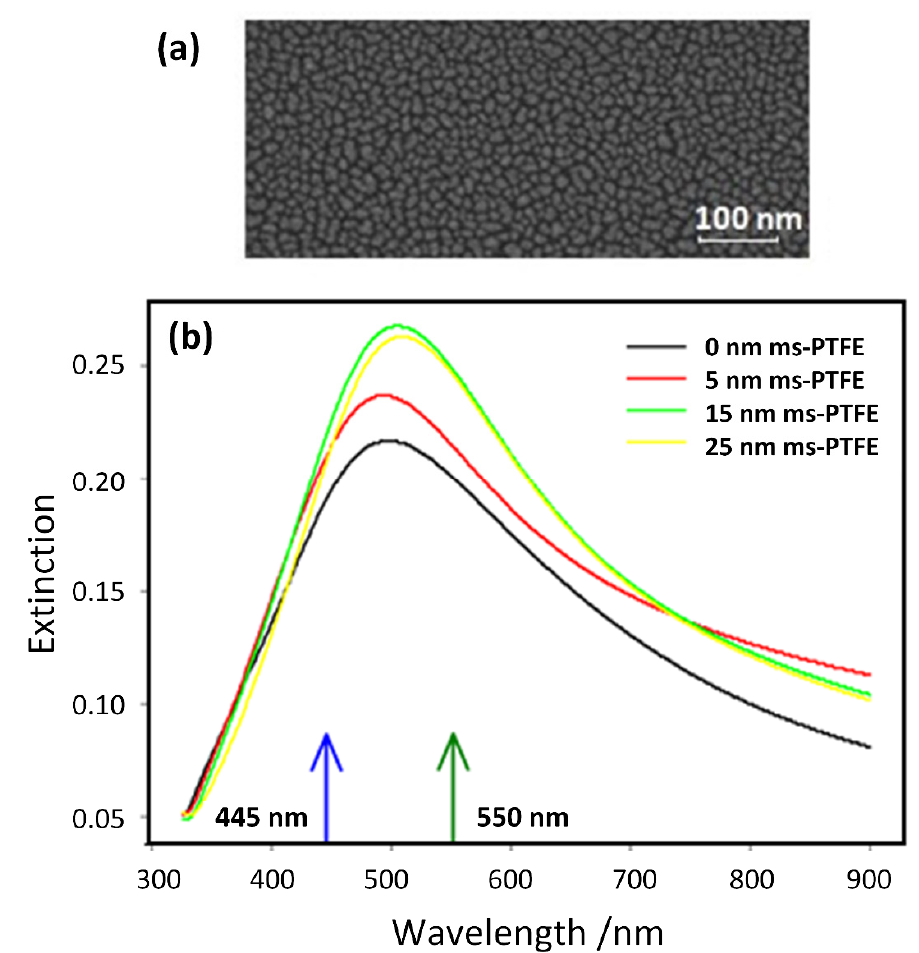
Figure 3. ( a ) Scanning electron microscopy (SEM) image of a typical Ag nanoisland layer, ( b ) extinction spectra of the Ag nanoislands overcoated with magnetron-sputtered polytetrafluoroethylene (ms-PTFE) layers of various thicknesses. The arrows indicate the excitation wavelength (blue) and the wavelength of the fluorescence maximum (green).